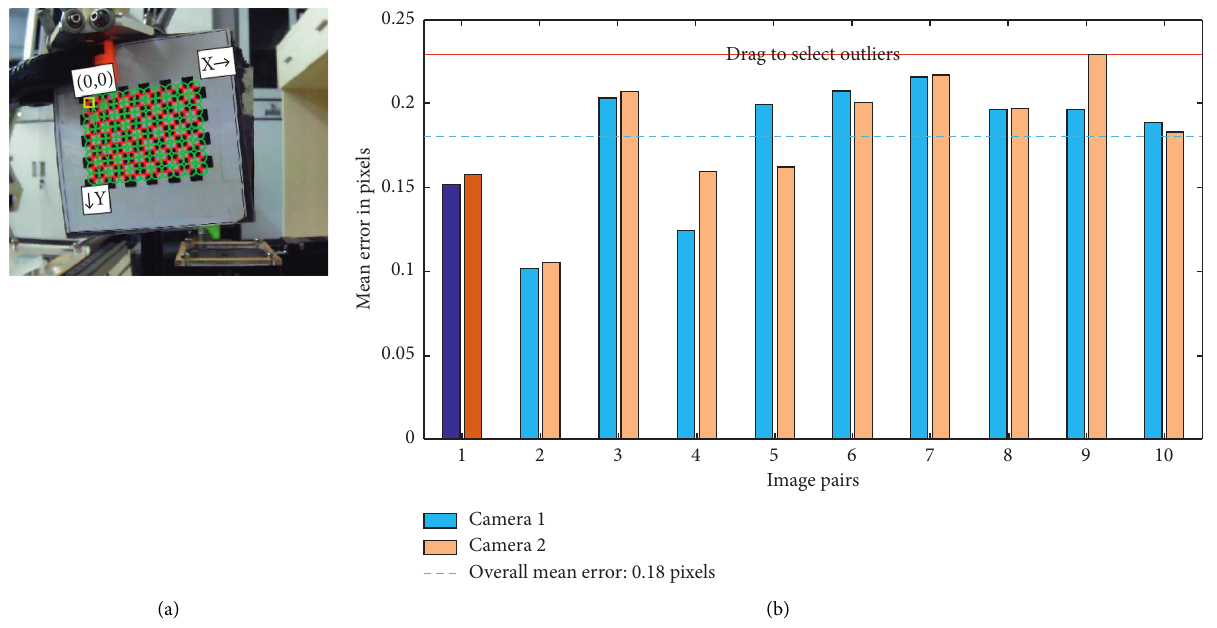
Figure 9: Checkerboard in calibration and the overall mean